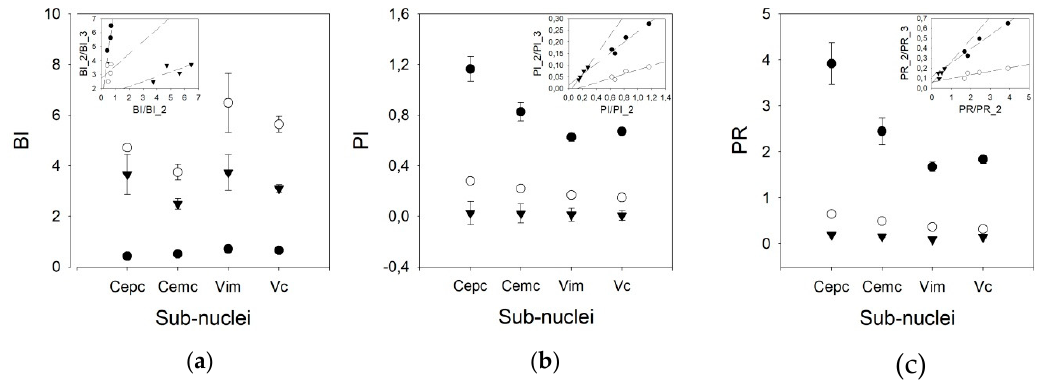
Figure 4. Graphs showing the values of ( a ) burst index (BI), ( b ) pause index (PI), and ( c ) pause ratio (PR) for all the nuclei for different pairs of times (solid dot = 10/50 ms, empty dot = 20/100 ms, and triangles = 50/200 ms). Insets represent linear regressions for the values obtained for all the nuclei using different pairs of times (solid dots = 10/50 vs. 20/100, empty dots = 10/50 vs. 50/200 and triangles = 20/100 vs. 50/200).